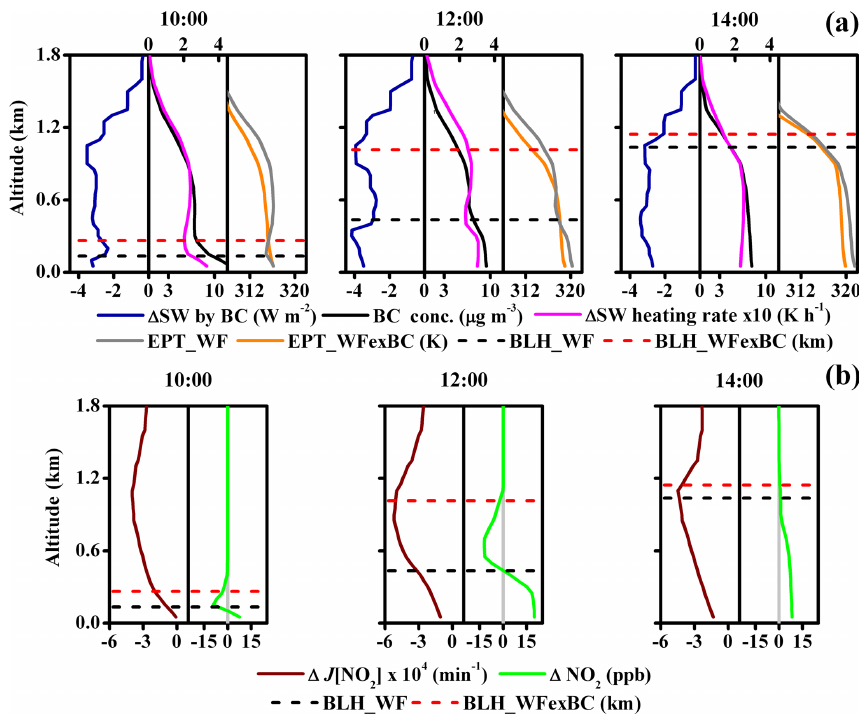
Figure 4. (a) Vertical distributions of averaged BC concentrations (black line; unit: µgm − 3 ), attenuation of incident shortwave radiation induced by BC (blue line; unit: Wm − 2 ), change of shortwave heating rate induced by BC (magenta line: unit: Kh − 1 ), and equivalent potential temperature (EPT; unit: K) of the two experiments (dark grey line for Exp_WF and orange line for Exp_WFexBC). (b) Average changes in J [NO 2 ] (brown line; unit: min − 1 ) and NO 2 (green line; unit: ppb) induced by BC in Nanjing at 10:00, 12:00 and 14:00LT. BLHs of the two experiments (black and red dashed line denote BLH in Exp_WF and Exp_WFexBC, respectively) are presented in both (a) and (b)